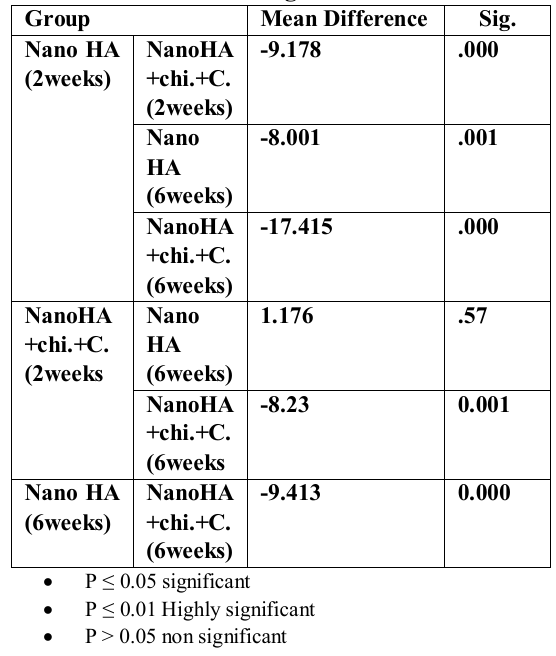
Table (3): multiple comparison